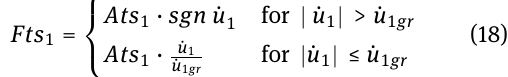
The actual elasticity characteristics of vehicle suspen- and tire separation from the ground were taken into